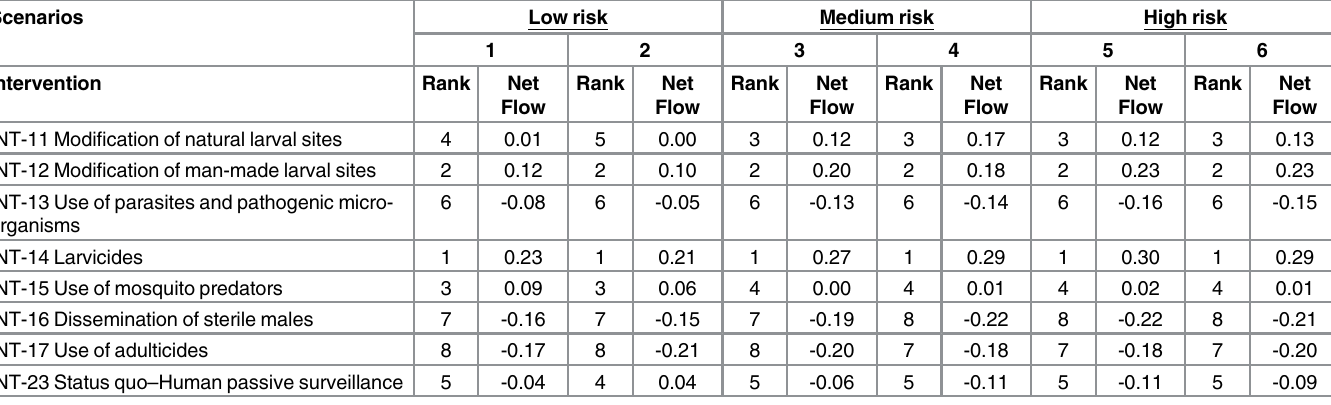
Table 6. Ranking of the mosquito-targeted control